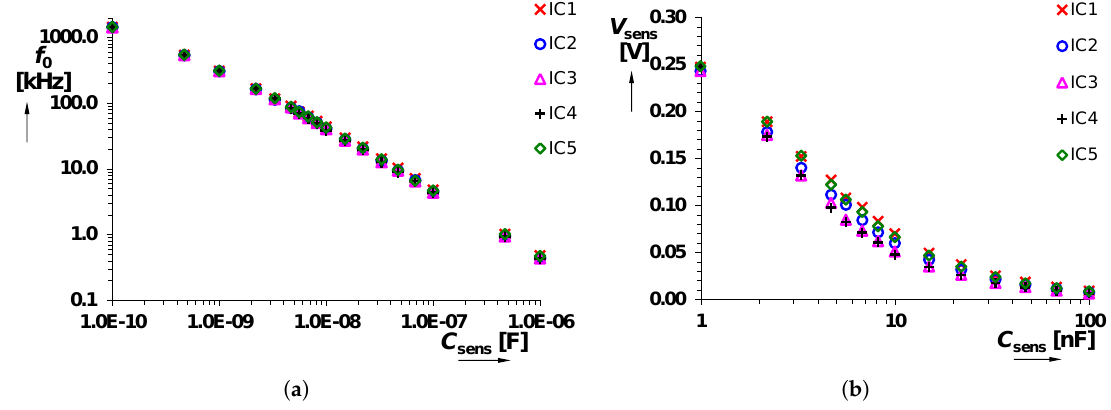
Figure 9. Comparison of the ( a ) f 0 versus C sens and ( b ) V sens versus C sens for 5 different IC packages (including CFOA